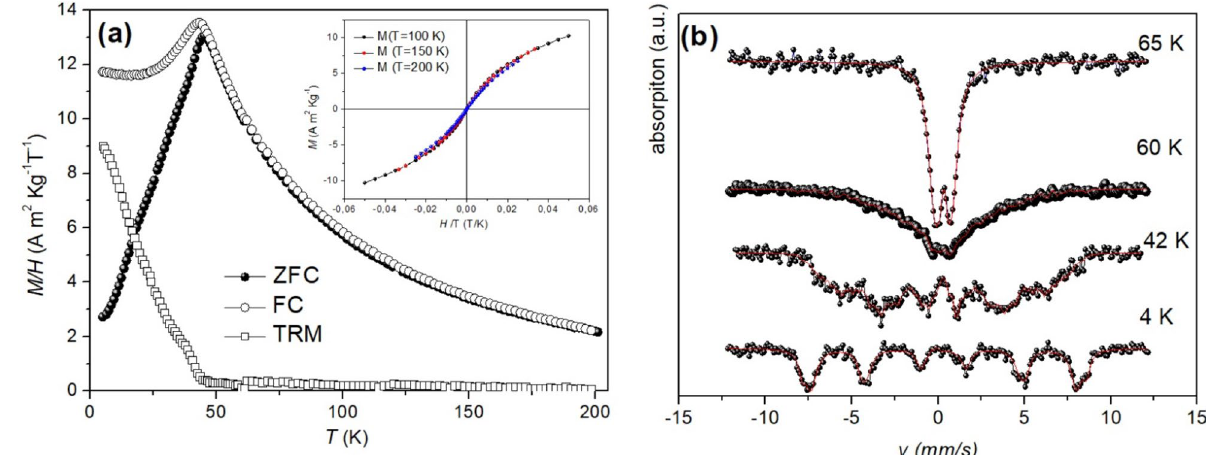
Figure 1. ( a ) ZFC (full circles), FC (empty circles) and TRM (empty squares) curves recorded in H = 10 Oe; inset M Vs (H/T) curves recorded in the range 100 – 200 K; ( b ) 57 Fe Mössbauer spectra of MnFe 2 O 4 samples recorded in the range 4–65